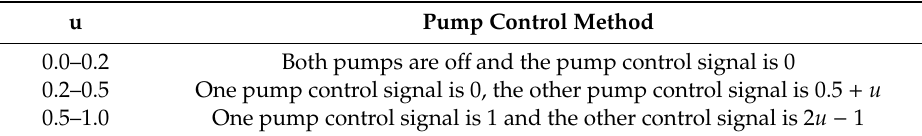
Table 2. Pump control strategy.